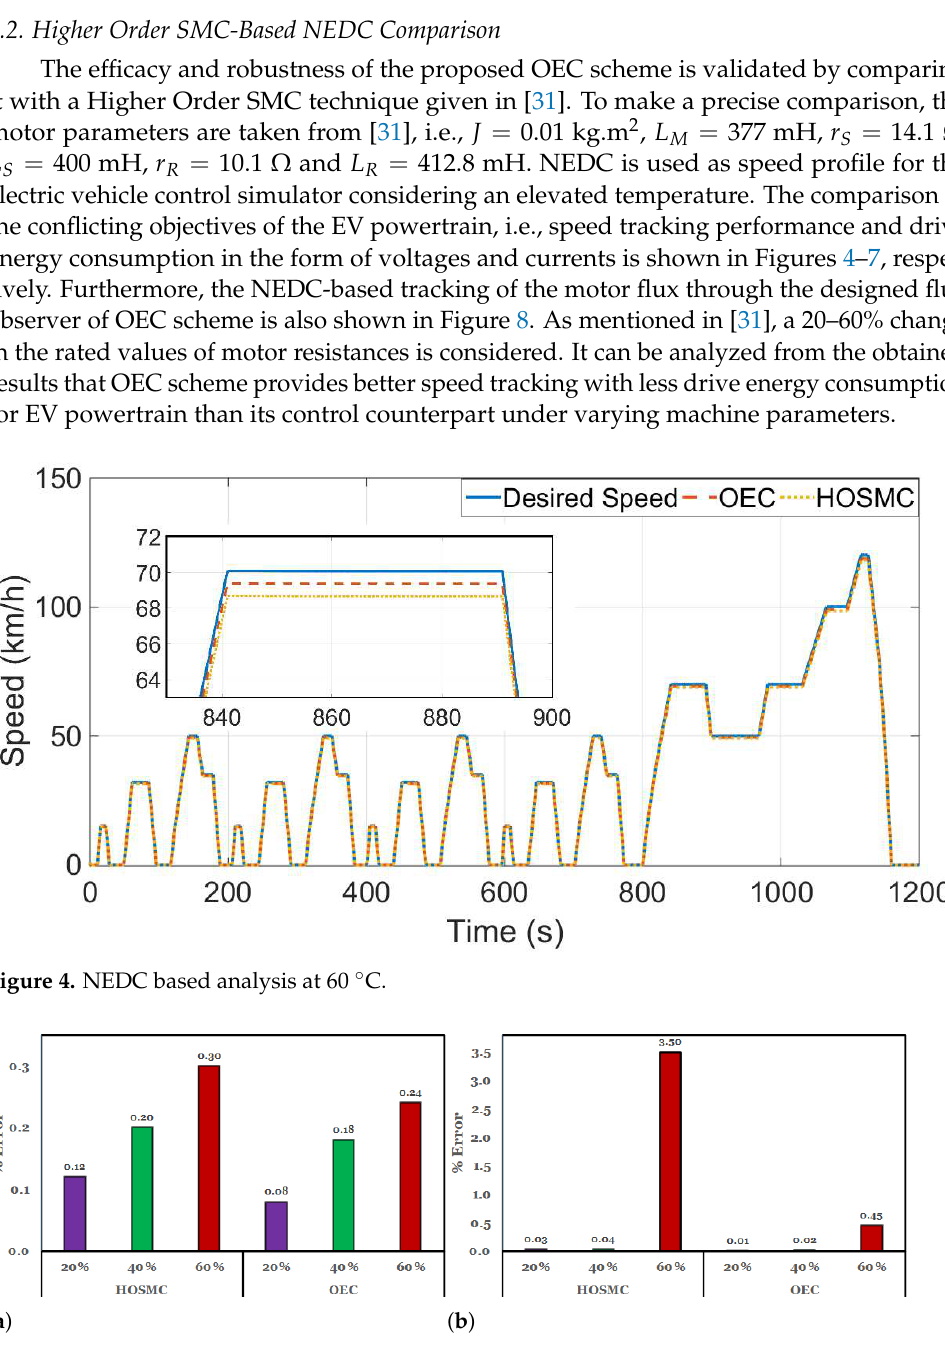
Figure 5. EV Speed tracking performance comparison ( a ) for stator resistance variation ( b ) for rotor resistance